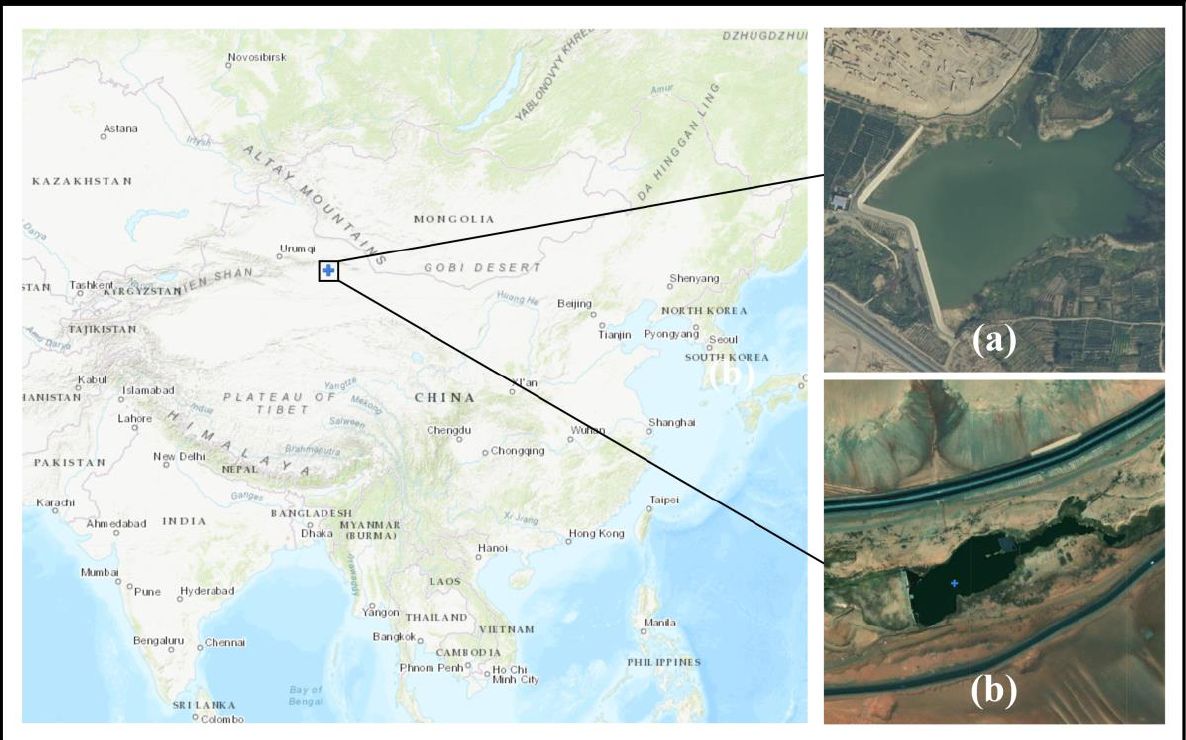
Figure 1. Geographic location of the reservoir in the test area. ( a ) Shengjintai Reservoir; ( b ) Shengjintai Phase III water and soil conservation reservoir.